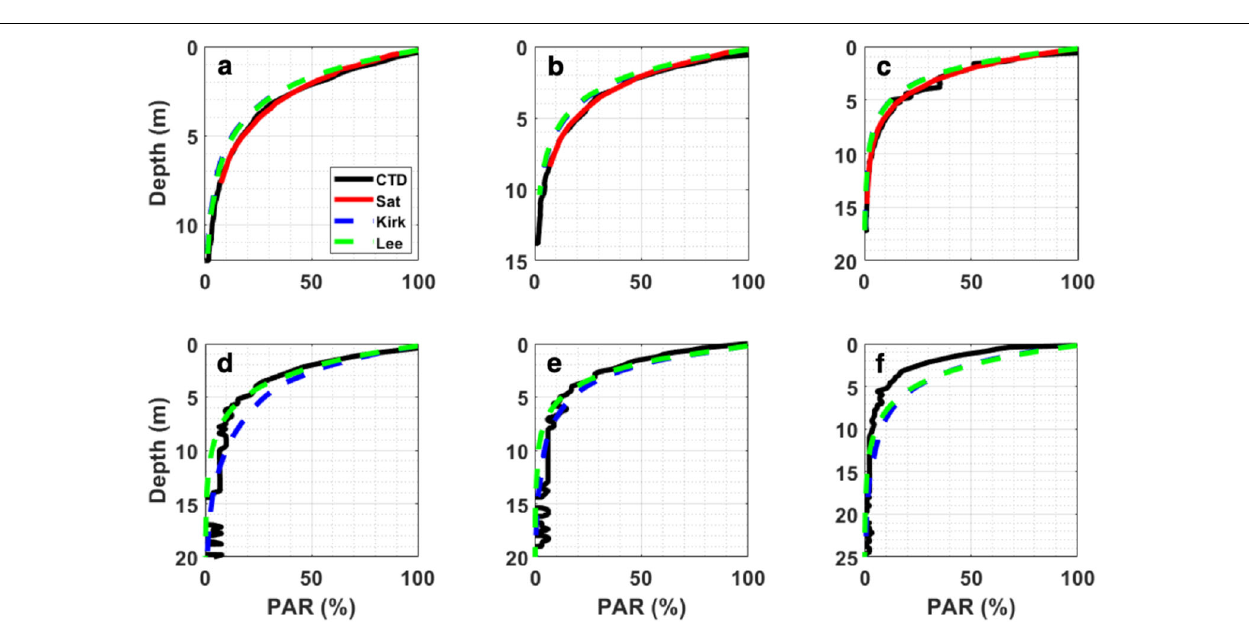
FIGURE 5 | Examples of profiles of in situ measured [PAR-CTD (a–f) and PAR-Sat (a–c) , the latter available only for measurements performed during the calibration exercise in June 2019] and AC-S-derived PAR [PAR-Kirk (a–f) and PAR-Lee (a–f) ] for selected sampling stations.